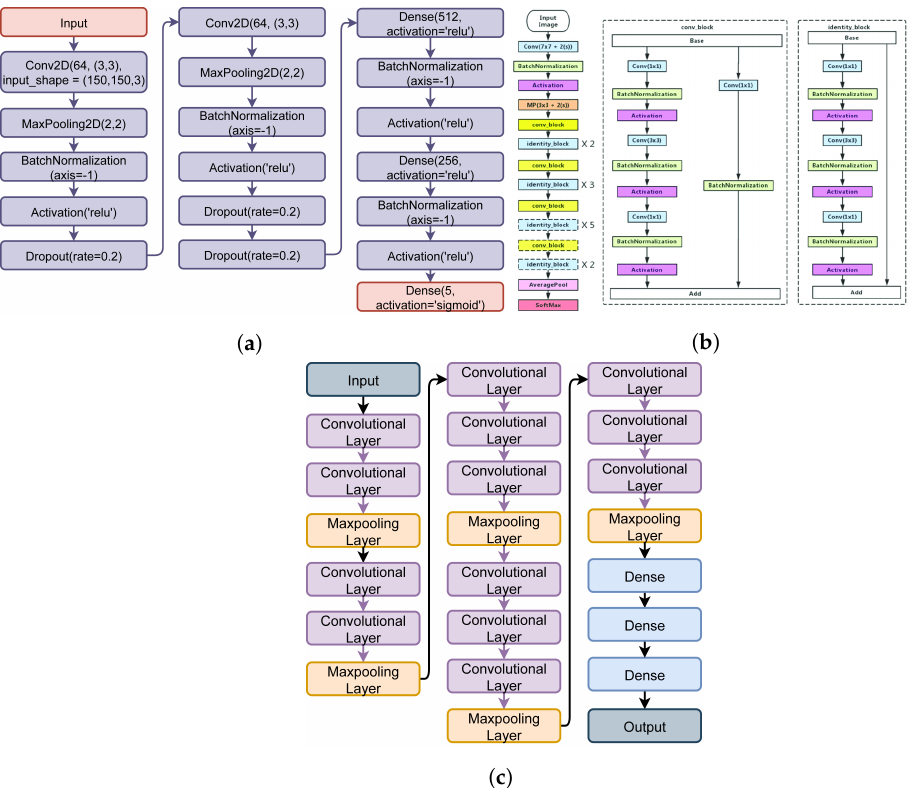
Figure 9. Architecture of the state-of-the-art deep learning models. ( a ) CNN, ( b ) ResNet50 [41], and ( c )